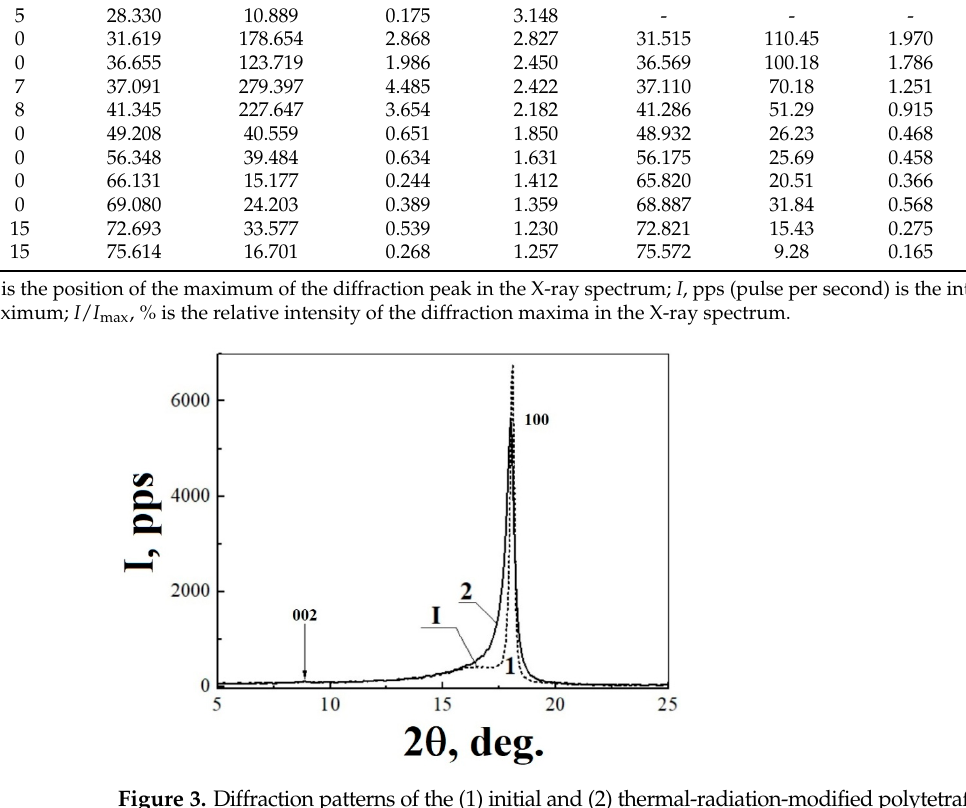
Polymers 2021 , 13 , x FOR PEER REVIEW